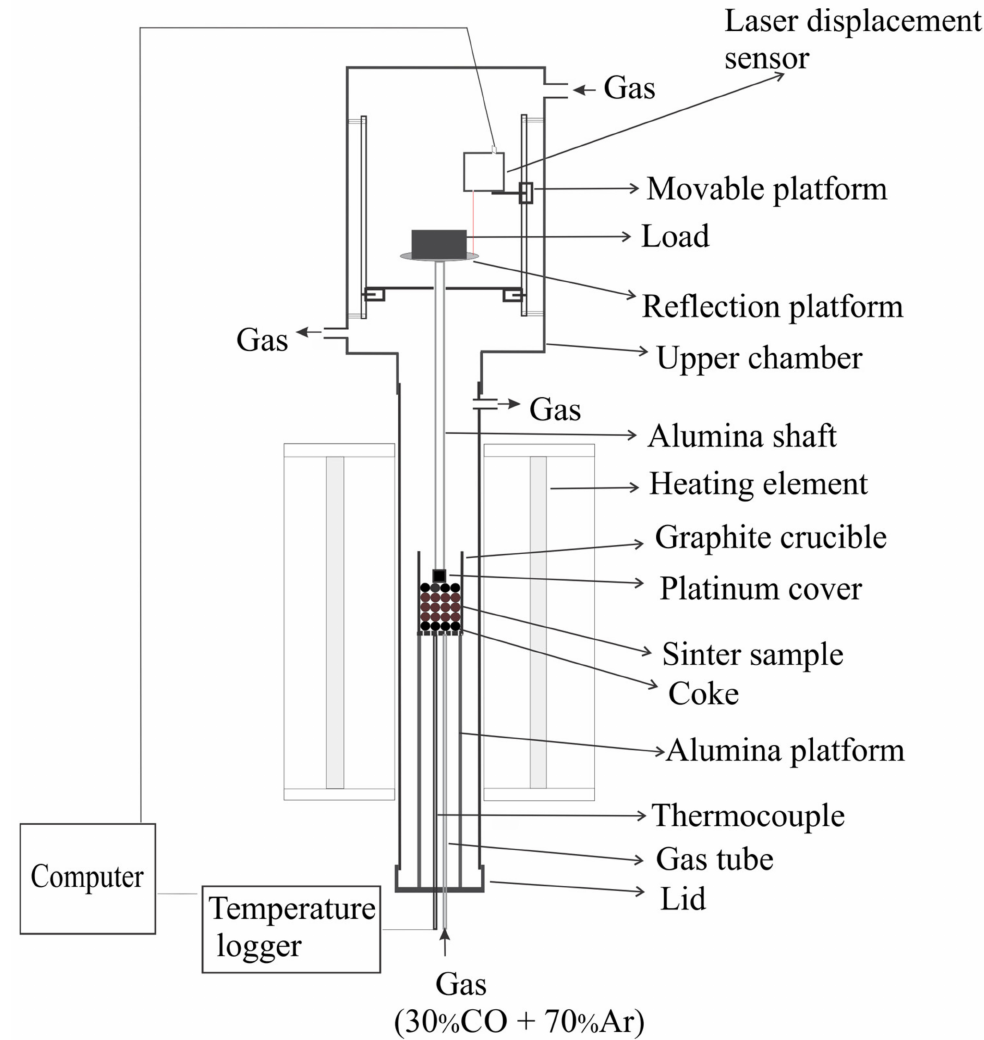
Figure 1. Schematic diagram of Pyrox furnace used for softening and melting test along with the sandwich bed containing coke and sinters, and laser displacement